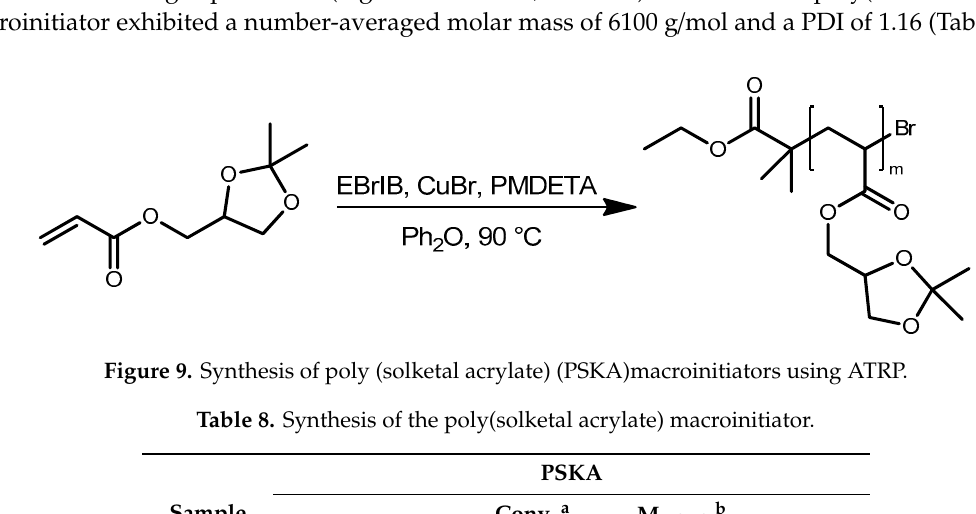
18 of 25 Table 7. Composition, number-averaged molecular mass and polydispersity (PDI) values of the block copolymers after centrifugation. sample